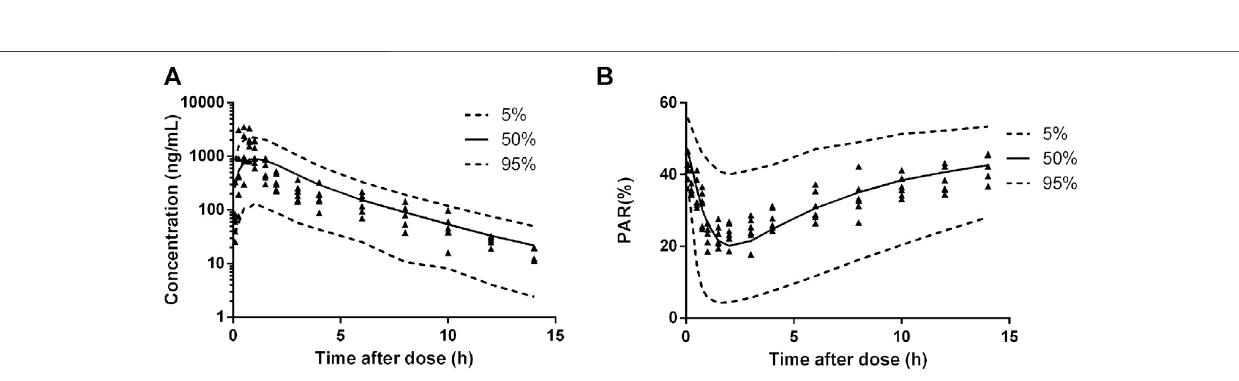
FIGURE 6 | Predicted plasma HY-021068 concentration-time pro fi les (A) and PAR (B) in beagle dogs on the 7th day following oral 5 mg/kg administration for consecutive 7 days (n (cid:2) 6). Solid and dashed lines depict median and 90% CI of model predictions.